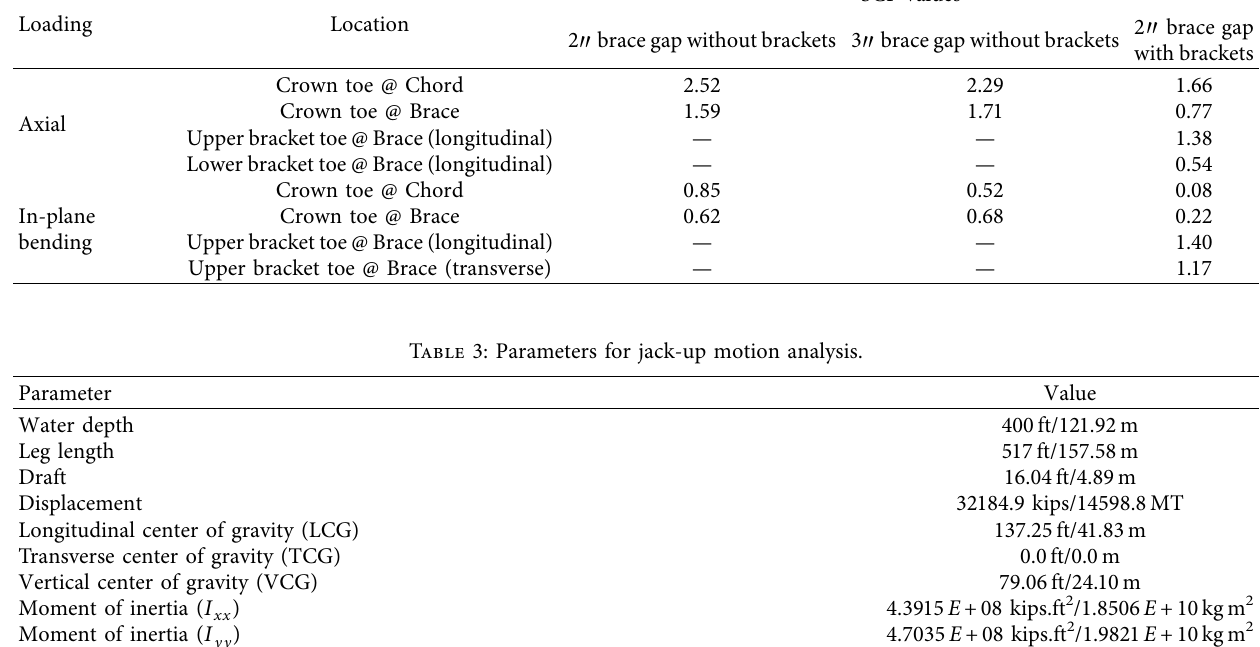
Table 2: SCF results for the two-planar overlapped KT-joint under different loadings and design conditions. Loading